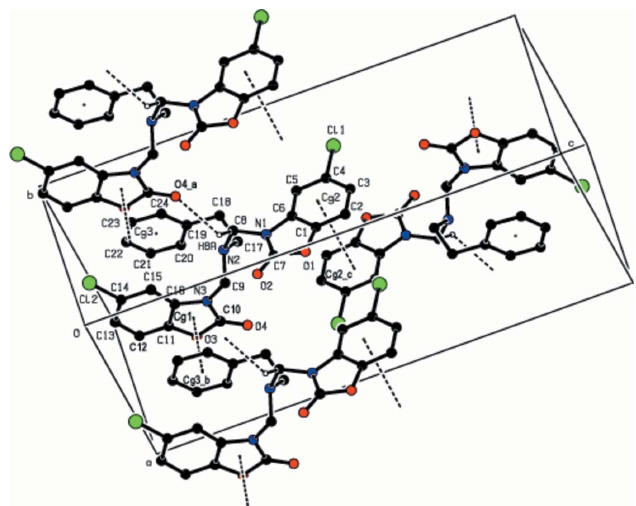
Figure 2 Aview of the crystal packing in the title structure, showing the C—H (cid:3)(cid:3)(cid:3) O hydrogen bonding and (cid:2) – (cid:2) stacking interactions. H atoms not involved in hydrogen bonds are omitted for the sake of clarity. [Symmetry codes: ( a ) x (cid:4) 1, y , z ; ( b ) x , y (cid:4) 1, z ; ( c ) 1 (cid:4) x , 1 (cid:4) y , 1 (cid:4) z .]